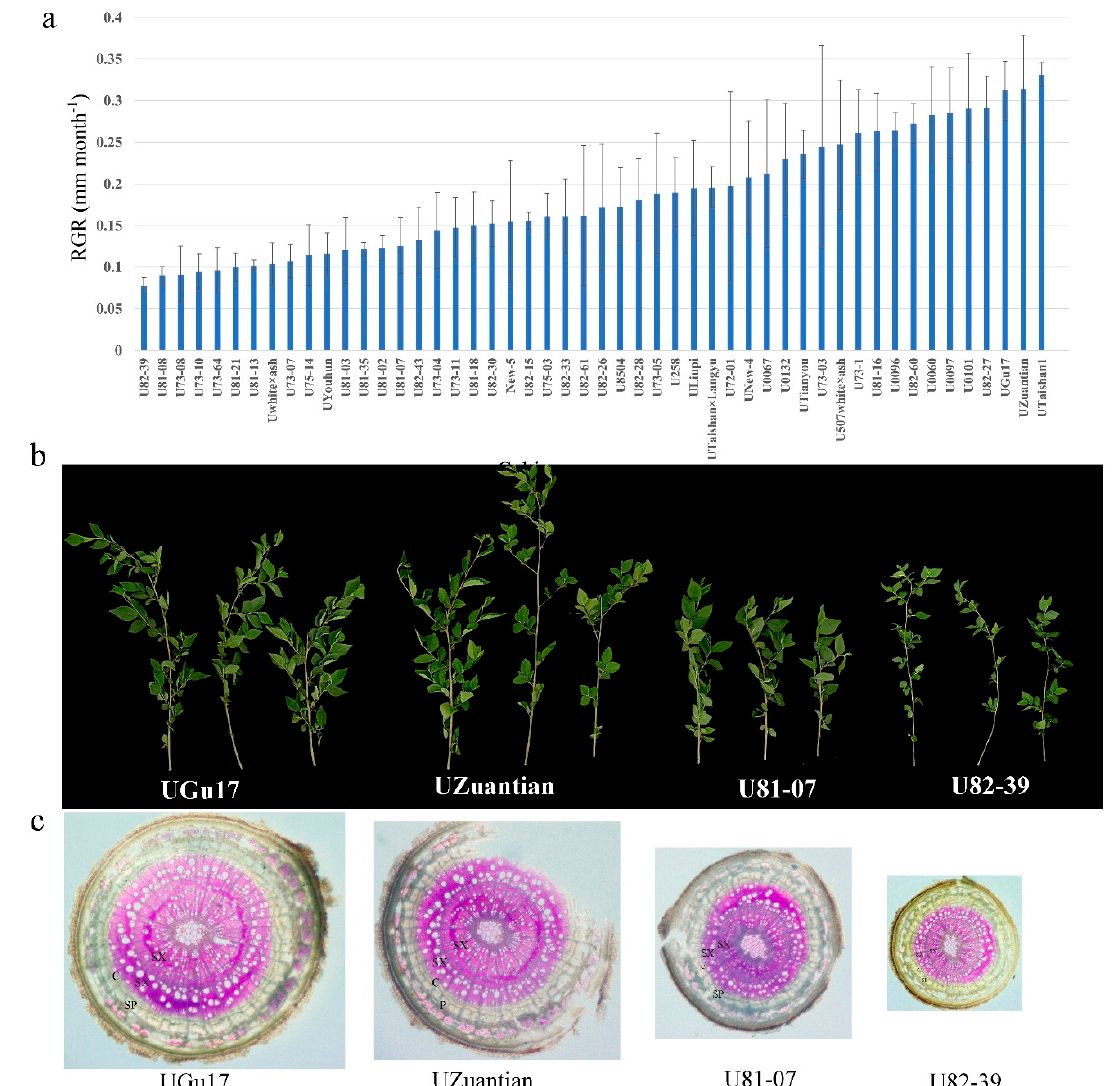
Figure 1. ( a ) The relative growth rates (RGR) of 50 elm cultivars from the Baiwa Forestry Centre. The variation range of RGR is 0.07–0.24 mm month − 1 , the average is 0.181 mm. The cultivar UTaishan1 has the highest BD (0.24) and the cultivar U82-39 has the highest BD (0.77). Error bars indicate SE. ( b ) The branch phenotypes of fast- (UGu17 and UZuantian) and slow-growing cultivars (U81-07 and U82-39). ( c ) Photomicrographs of branch cross-sections of fast- (UGu17 and UZuantian) and slow-growing cultivars (U81-07 and U82-39). C, cambium region; SP, secondary phloem; SX,